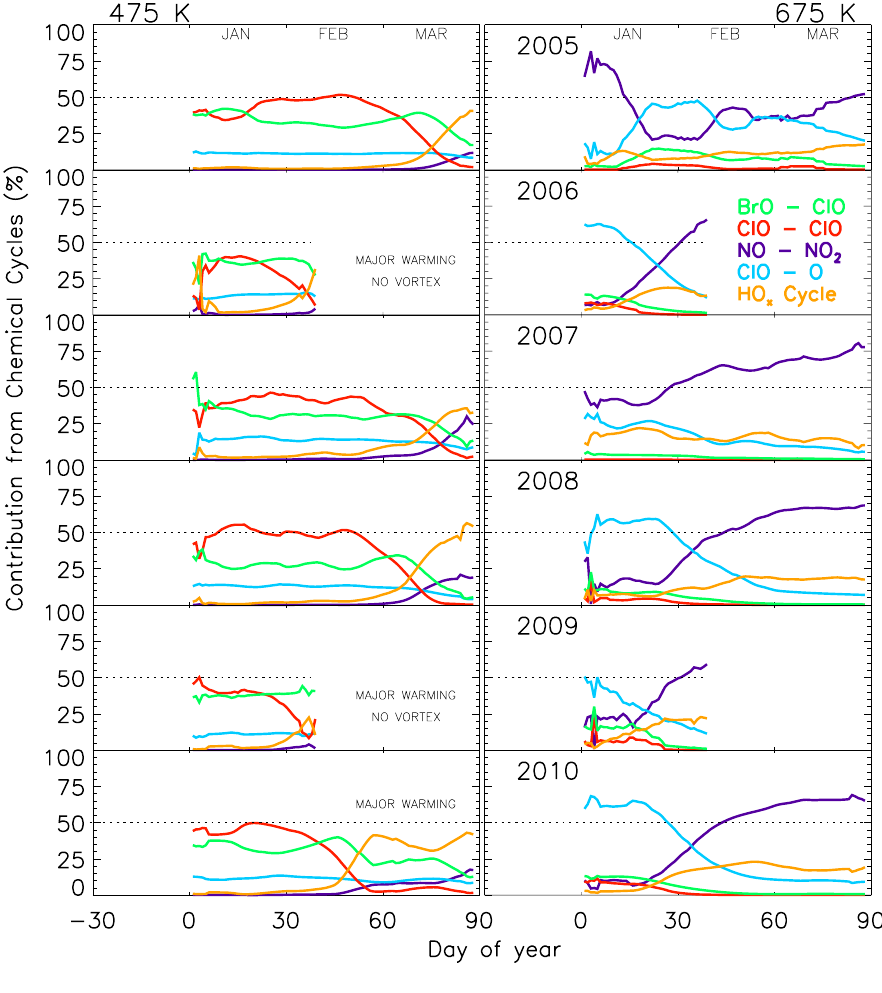
Fig. 8. Vortex averaged ( ≥ 65 ◦ EqL) relative contribution of selected ozone depleting chemical cycles to the total chemical ozone loss at 475 (left panel) and 675K (right panel) in the Arctic winters 2005–2010. The data are smoothed for ten-days. The dotted lines represent 50% and the top lines of each plot represent 100%